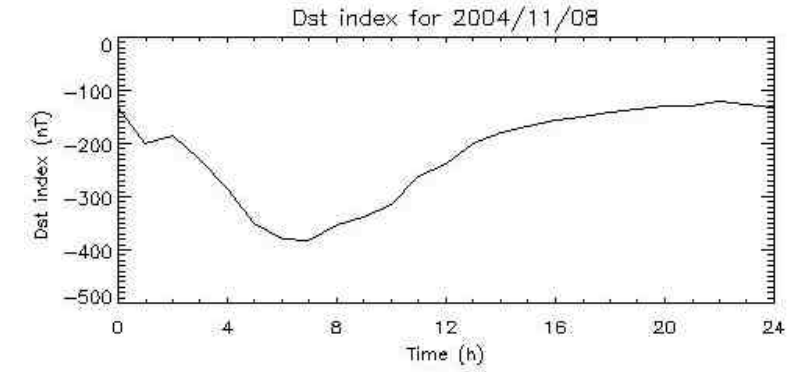
Fig. 6. D st index on 8 November